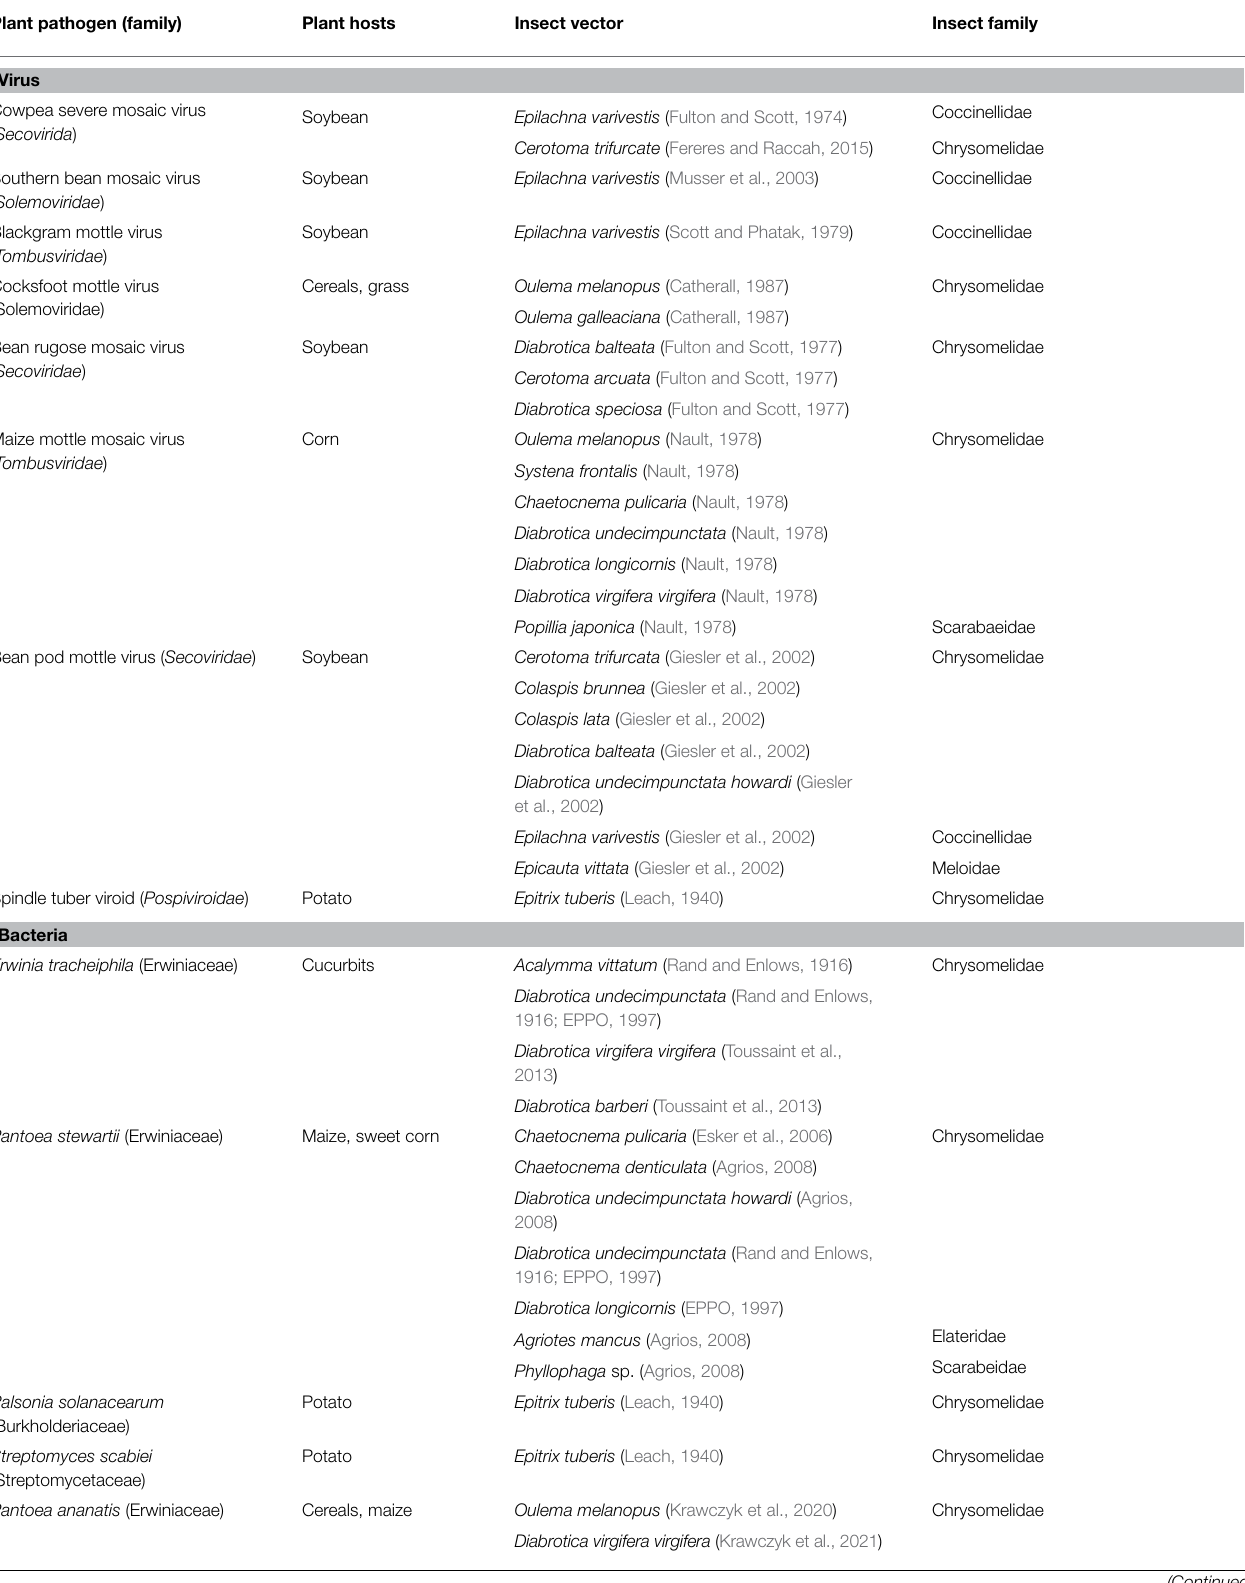
TABLE 1 | Beetle vectors of plant pathogens and their plant